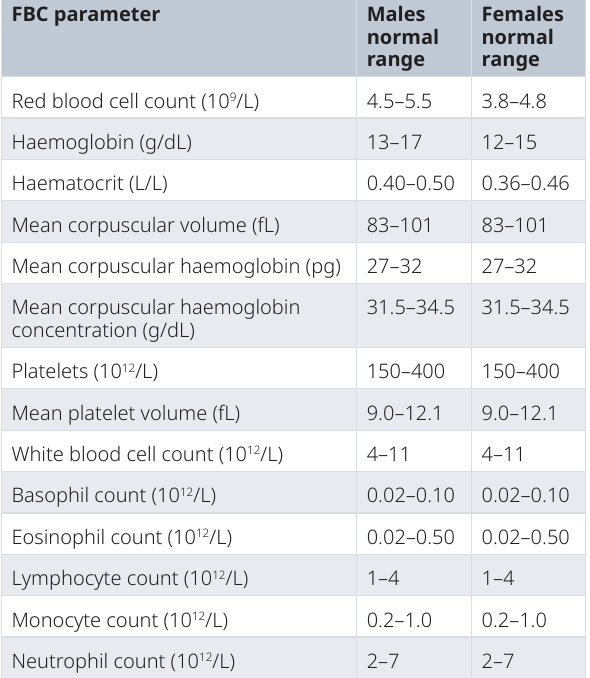
Table 4. Normal reference range for patients aged 13+ years for each FBC